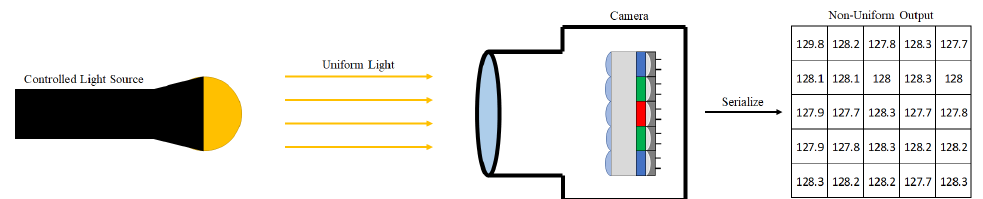
Figure 3. Visualizing photo-response non-uniformity. Photo receivers are imperfect due to manufac- turing tolerances. When a uniform light is presented to the camera, a unique, non-uniform response is